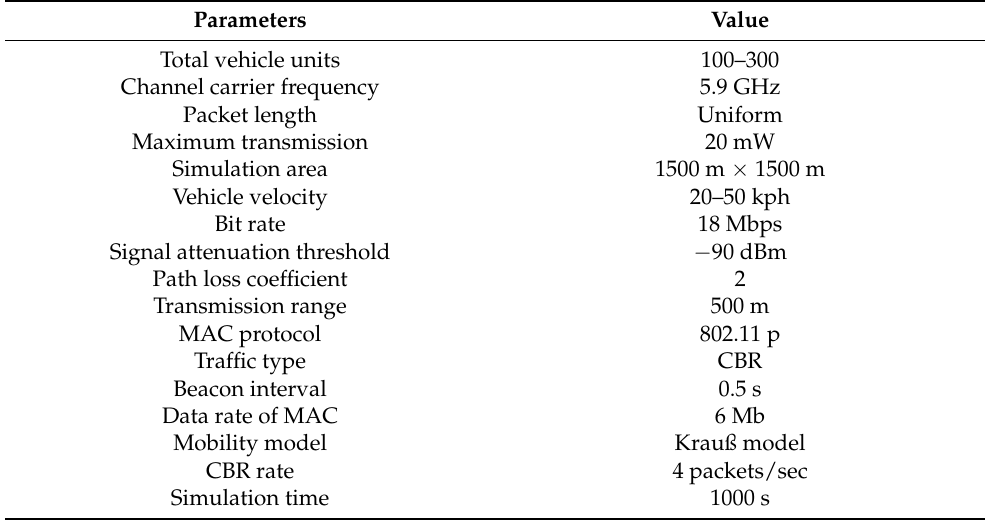
Table 1. Simulation